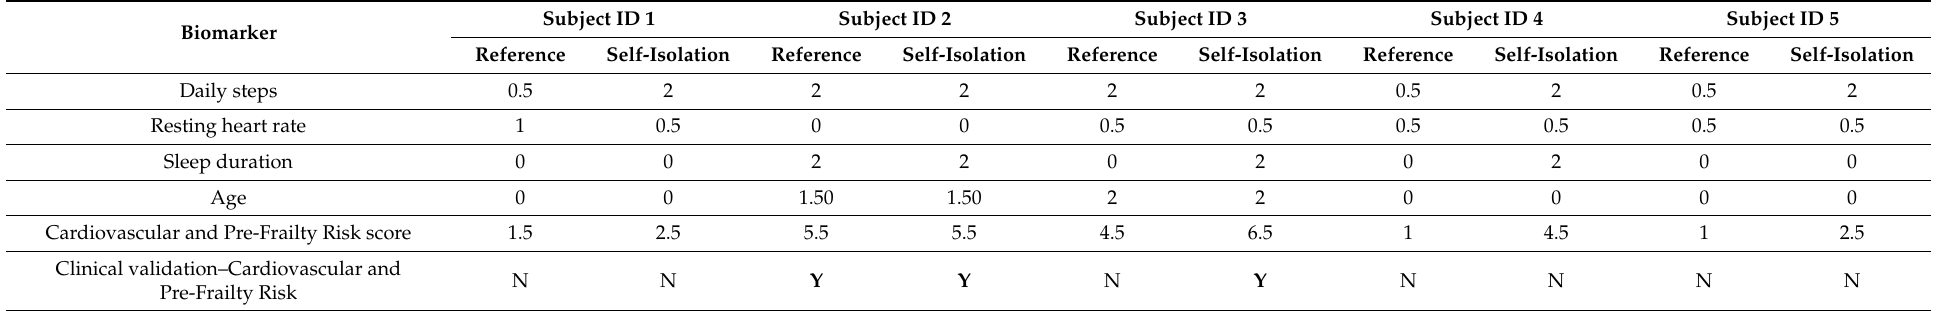
Table 4. Cardiovascular and Pre-Frailty Risk Assessment (reference versus